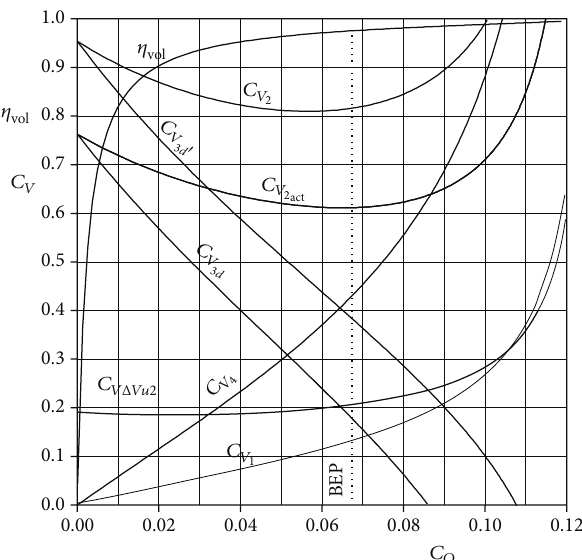
Figure 15: Values of volumetric efficiency and different pump velocity coefficients.